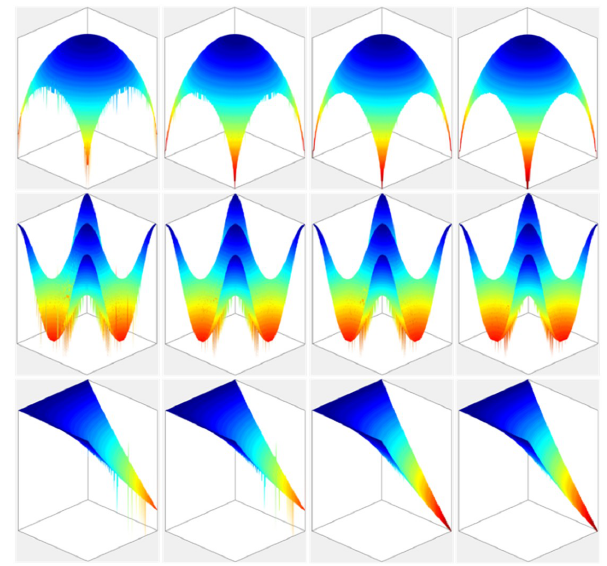
Figure 16. Initial depth map of the three models reconstructed using different evaluation windows of F TEN.